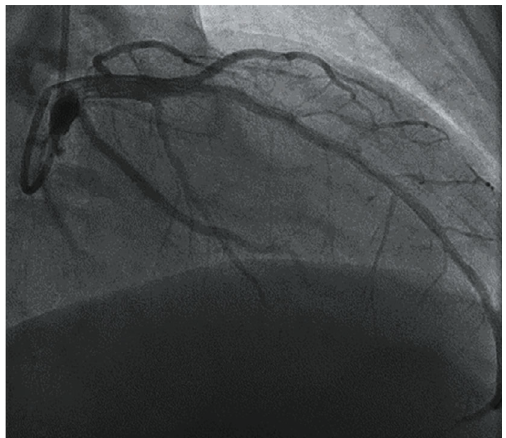
Figure 1: Coronary angiography showing no dissection of the left main coronary